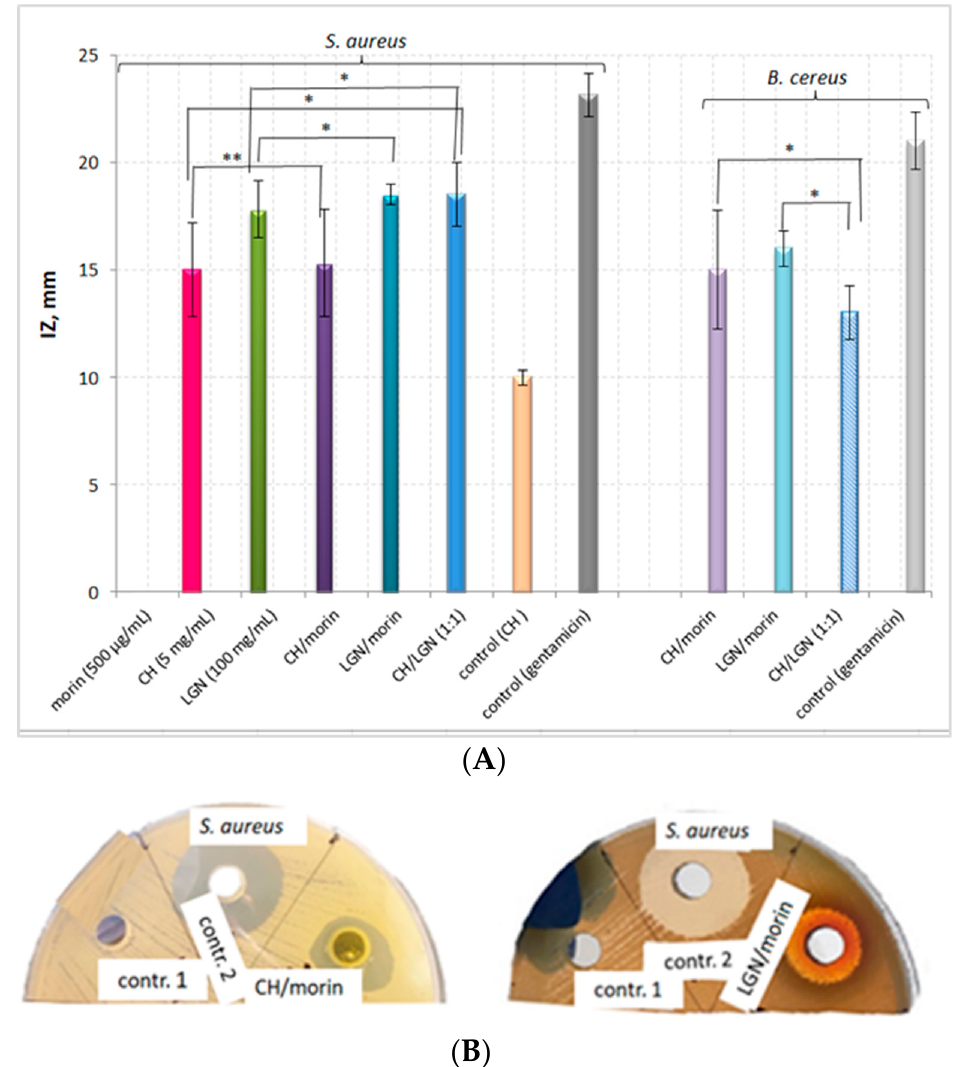
Figure 2. Antimicrobial potential of single- and two-component morin–biopolymer, biopolymer– biopolymer systems against S. aureus and B. cereus . (Statistical significance of the experimental results: * p < 0.005; ** p = 0.073.): ( A ) Graphical representation of the experimental data, ( B ) Photos of the inhibition zones against S. aureus .